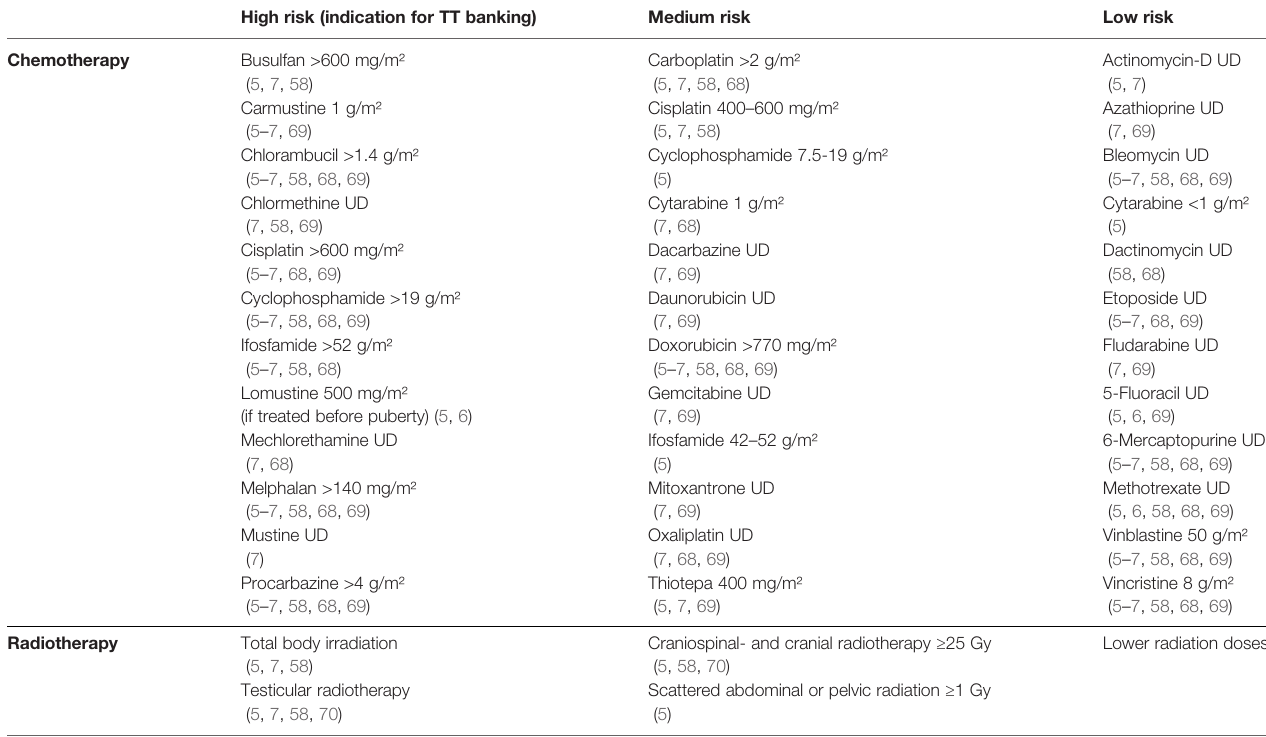
TABLE 1 | Estimated risk of prolonged azoospermia with chemo- and